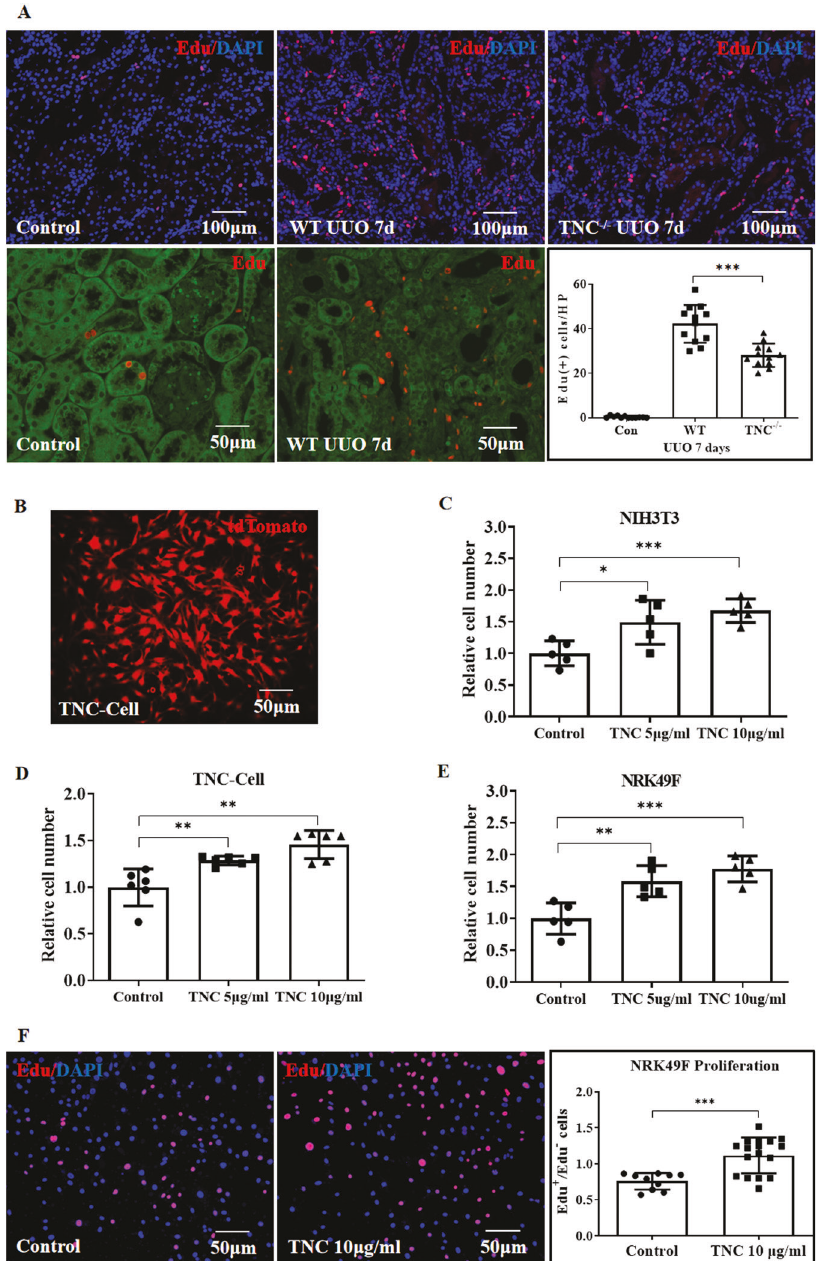
type mouse ( A , n = 4 mice, 3 slides for each mouse, p < 0.05). To further examine the effect of TNC on cell proliferation, TNC-expressing cells (TNC-Cell) were obtained by sorting the tdTomato-positive cells in UUO kidneys, and then immortalized by transfecting SV40 T lentivirus ( B